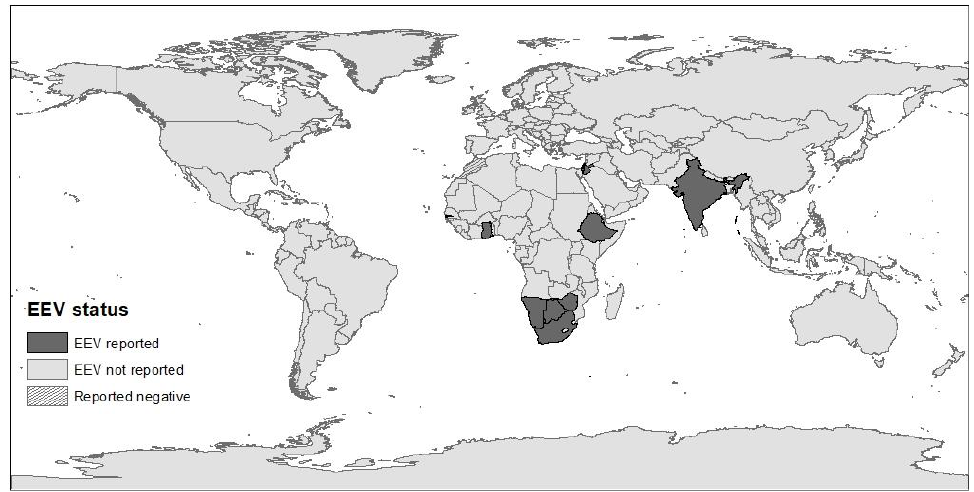
Figure 2. The global distribution of EEV, according to serological and molecular studies. The map was constructed using ArcMap (ArcGIS Desktop 10.6.1, Esri Inc.©, Redlands, CA, USA). EEV is endemic in Africa and in the Middle East, with seroprevalence ranging between 60% and 100% in Gambia, Ghana, Ethiopia, Israel, South Africa, and Zimbabwe [5,6,8,10,29]. Studies from South Africa and Israel revealed fluctuations in the annual seroprevalence and incidence of EEV, which may be influenced by weather, climate, herd immunity, and the distribution of Culicoides vector species [5,6,22,23]. Spatial and temporal studies from South Africa showed that EEV seroprevalence and the abundance of specific EEV serotypes differ between geographical provinces, but also between districts within the same province [5,22,23]. All EEV serotypes have been identified in all South African provinces, but the relative abundance of each serotype varied between areas and even between farms. In each area and season, there was usually one predominant circulating serotype (with demonstrated seroconversion), while others were only isolated sporadically [5,14,22]. However, similar serotypes were identified in horses and Culicoides in the same area [5]. It has been demonstrated that individual horses can be simultaneously seropositive to several serotypes, which indicates that there is no sufficient immunological cross-protection between serotypes against infection [5,14,22,30].